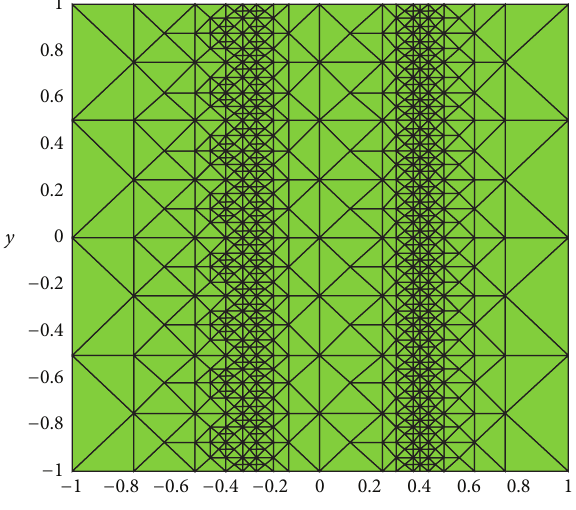
Figure 6: The mesh of the radial dam-break problem at 𝑡 = 0.05 using the adaptive method. The 𝑥 -axis is horizontal. The 𝑦 -axis is